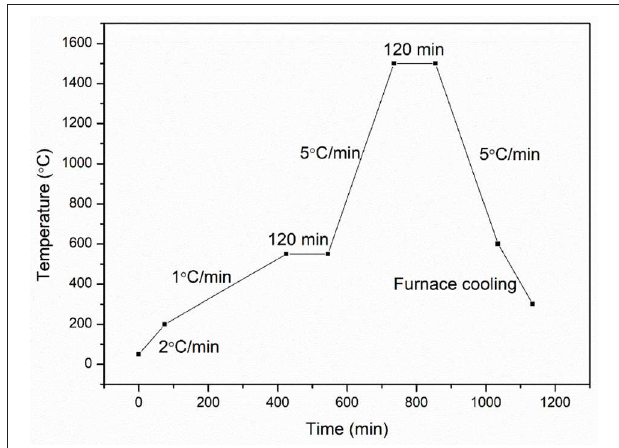
FIGURE 2 | Debinding and sintering process of the green